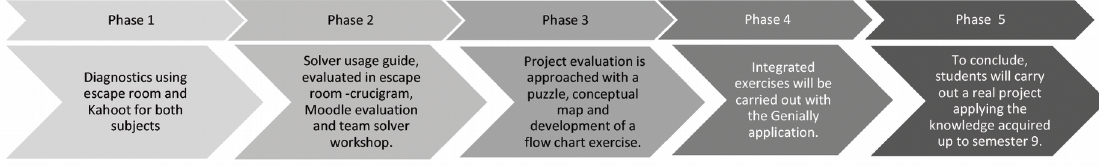
Figure 3. Stages of activities of the course